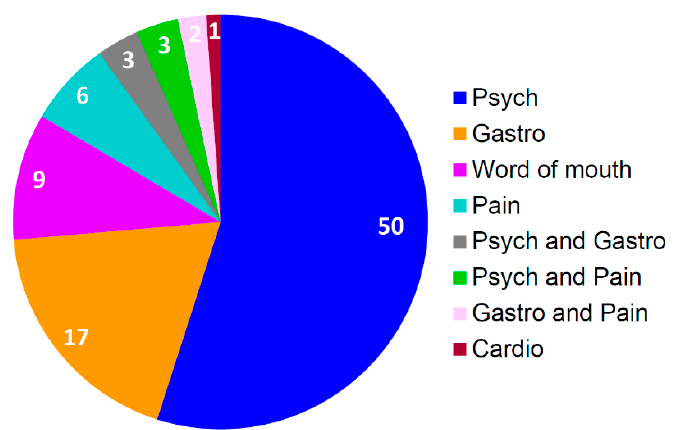
Figure 4. Number of referrals to the pharmacogenetics consult clinic by referral type (i.e., therapeutic area(s) of medication(s) identified by referring internal medicine physician as warranting drug therapy optimization with pharmacogenetics [n = 91], based on suggested referral criteria).